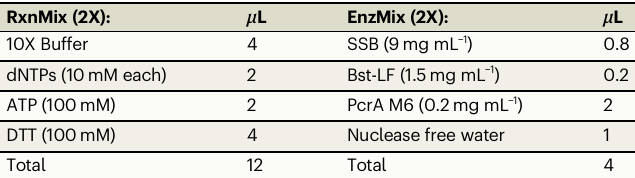
Table 2 | Premixed SHARP components for ampli fi cation of genomic